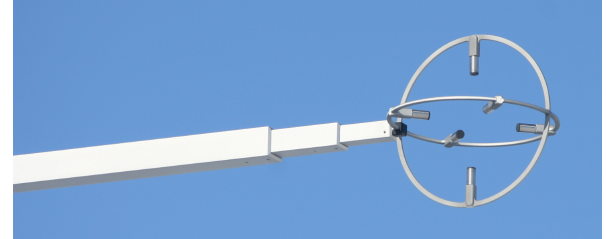
Figure 1. Photograph of the sonic anemometer used for TILDAE. The sensor head (right) incorporates six transducers, which are mounted in the cylindrical housings that protrude inward from the metal rings. The effective distance between oppositely positioned transducers is approximately